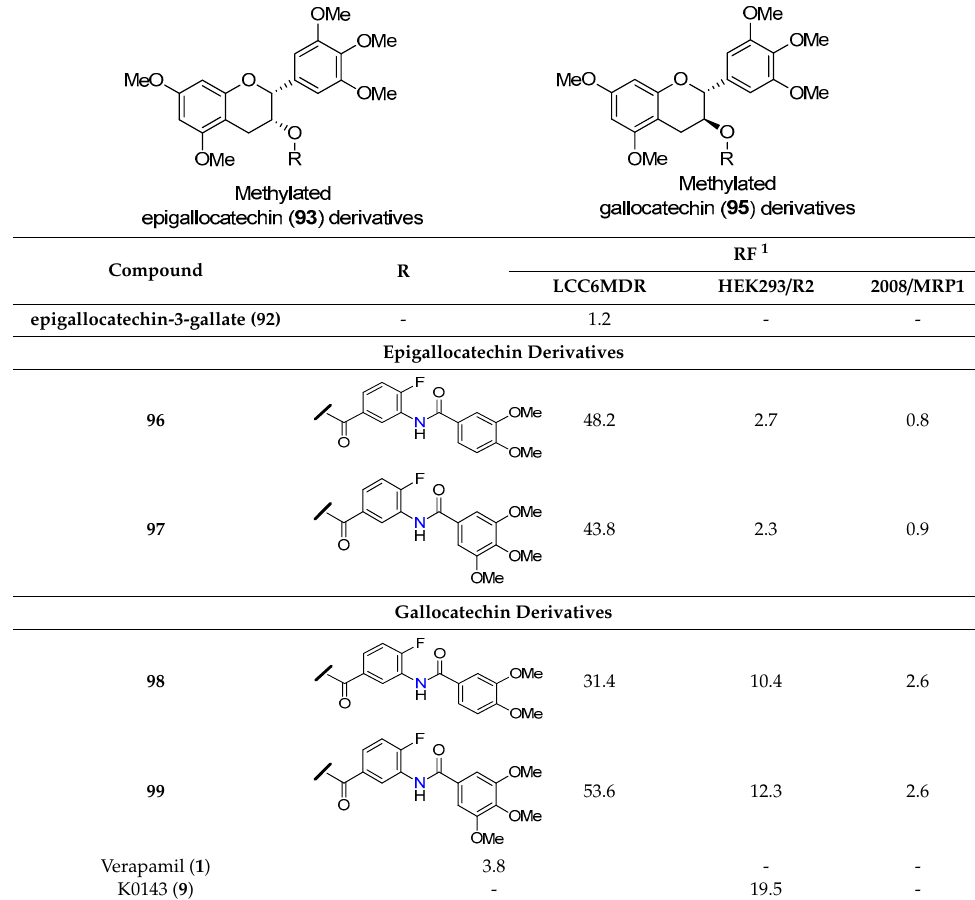
Structures of catechins: ( − )-epigallocatechin gallate ( 92 ), ( − )-epigallocatechin ( 93 ), ( − )- epicatechin gallate ( 94 ) and (+)-gallocatechin ( 95 ). Table 10. P-gp, BCRP and MRP1 reversal activity of epigallocatechin ( 93 ) and gallocatechin ( 95 ) derivatives 96 – 99 in LCC6MDR (P-gp), HEK293/R2 (BCRP) and 2008/MRP1 (MRP1) cells. Verapamil